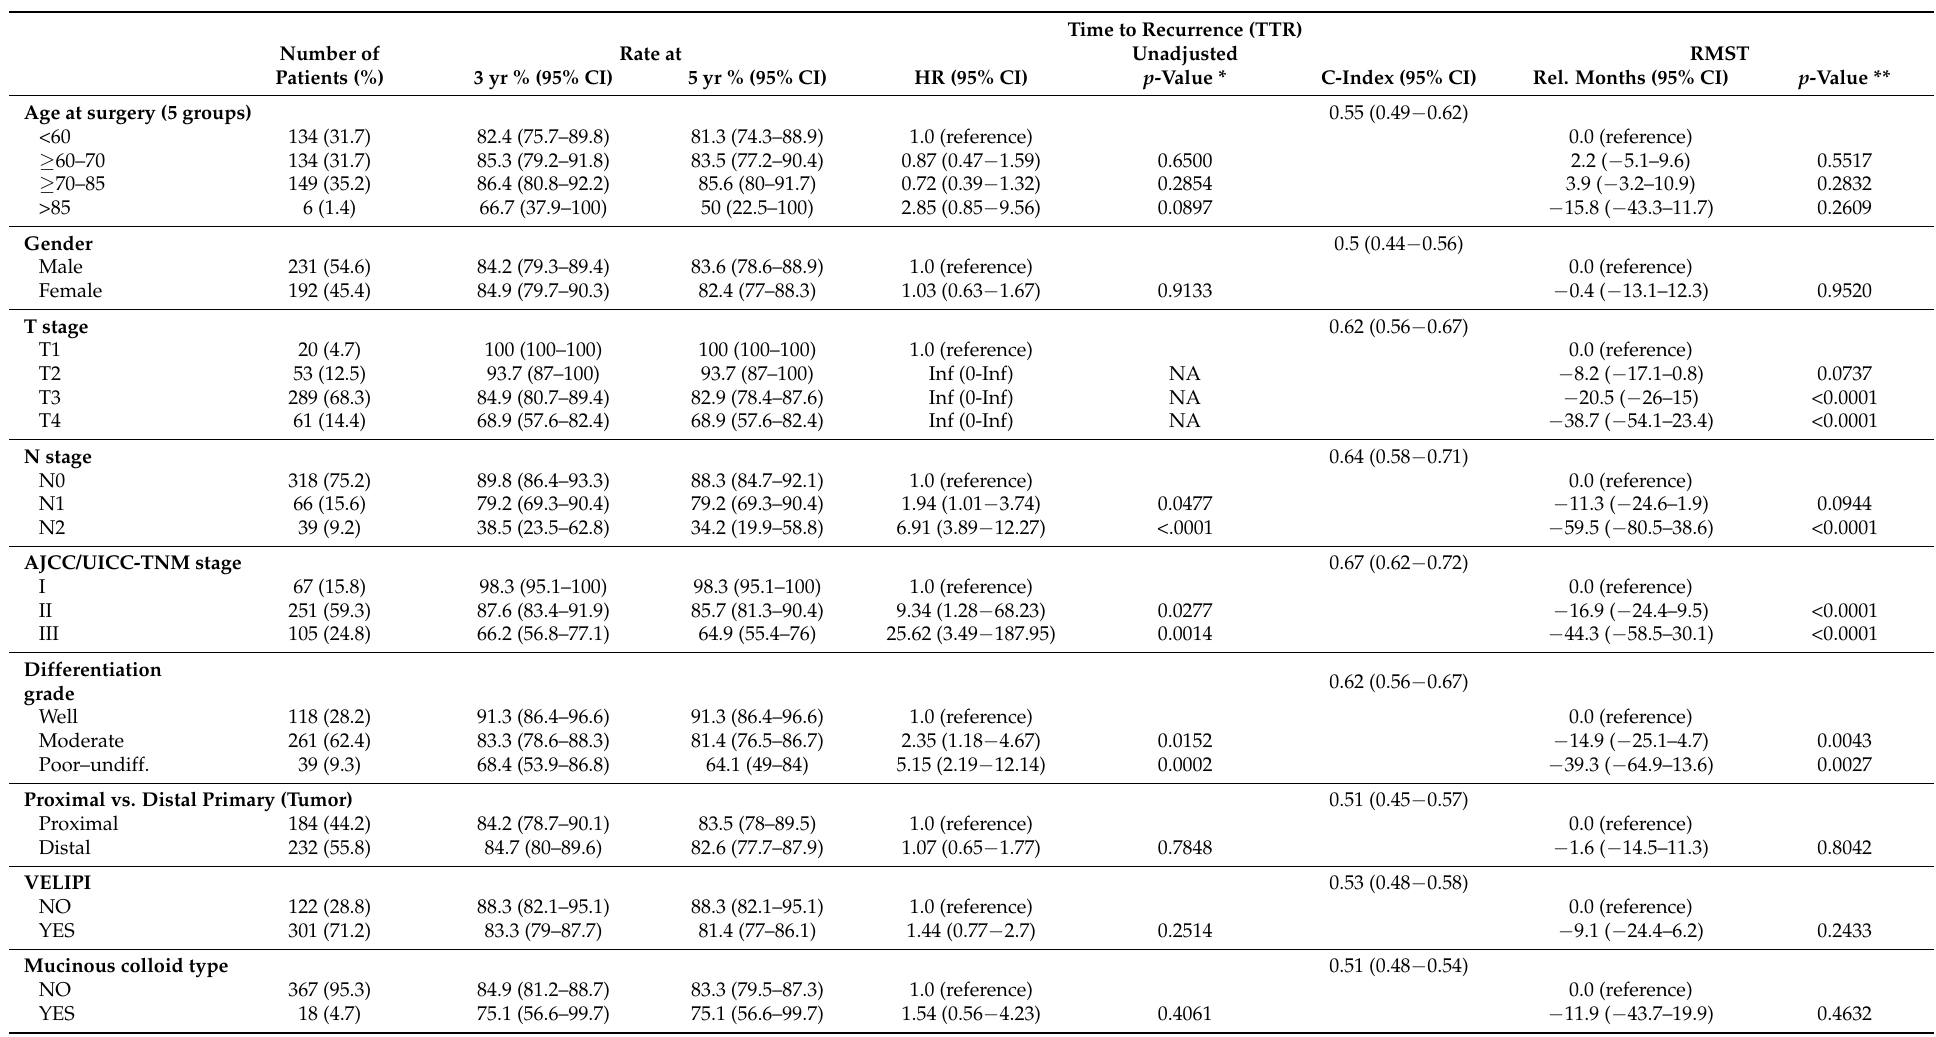
Table 1. Stage I–III bivariable analysis for clinical parameters for